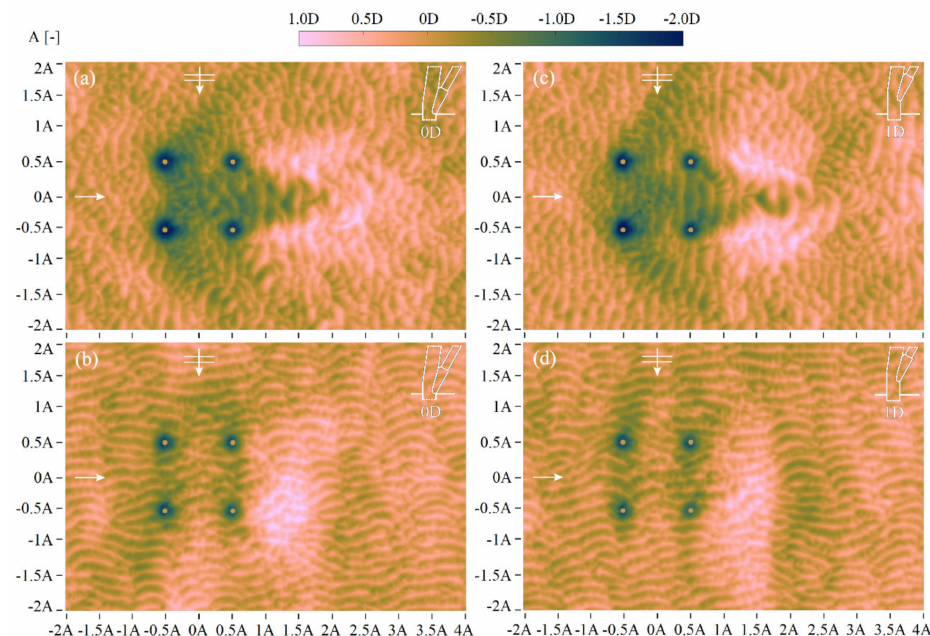
Figure 6. Surface elevation of Test 3 (panel ( a )) and Test 5 (panel ( b )) (node distance 0D) in top view. In addition, the bed topography of tests for the same hydrodynamic condition with an increased distance from the lowest node to the seabed (node distance 1D) is illustrated in ( c , d ). Dark blue and green represent erosion of sediment, while light brown represents the transition to deposed sediment. Distances are given in relation to the structure footprint reference length, which is 0.55 m in this study (e.g., 0.5A = 0.275 m / 0.55 m); the elevation is given in diameters with D = 4